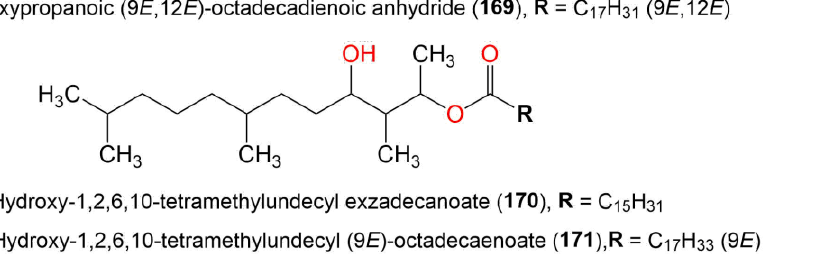
Figure 17. Structures of aromatic compounds ( 153 – 157 ), pyran ( 158 – 160) and furan (161 – 164 ) derivatives, and aliphatic acids ( 165 – 172 ) isolated from F. oxysporum .